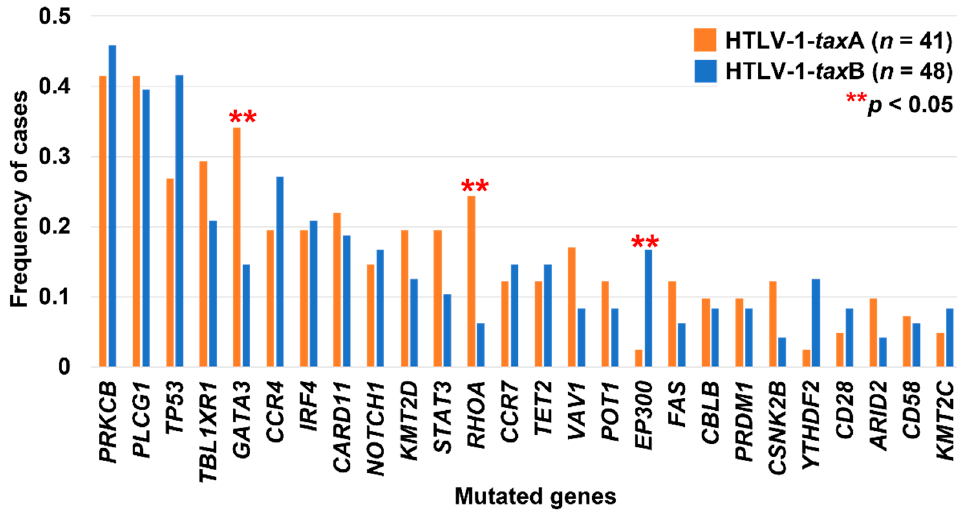
Figure 6. Associations between mutations and tax subgroups observed in our previous study [17]. p -values were calculated with two-sided Fisher’s exact test.